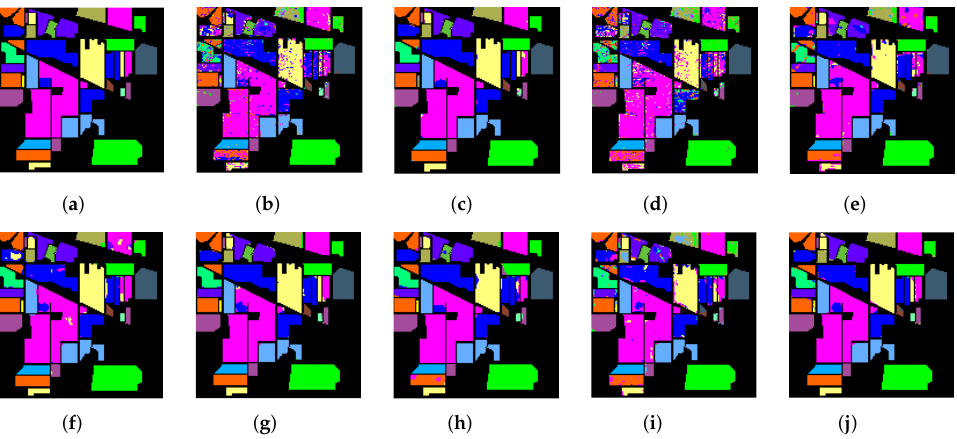
Figure 7. Classification results of ground truth and comparison methods for the IP dataset. ( a ) Ground Truth. ( b ) SVM. ( c ) SSRN. ( d ) 1D-CNN. ( e ) 2D-CNN. ( f ) FDSSC. ( g ) DBDA. ( h ) CECNN. ( i ) SF. ( j )